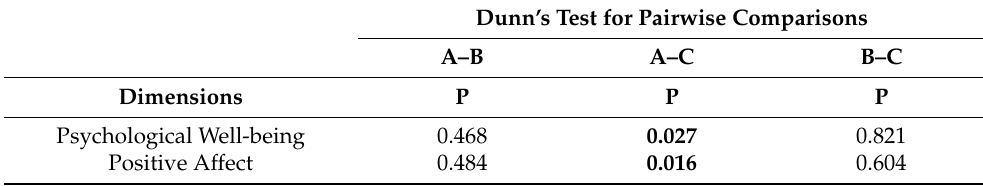
Table 2. Pairwise comparison results in Psychological Well-being and Positive